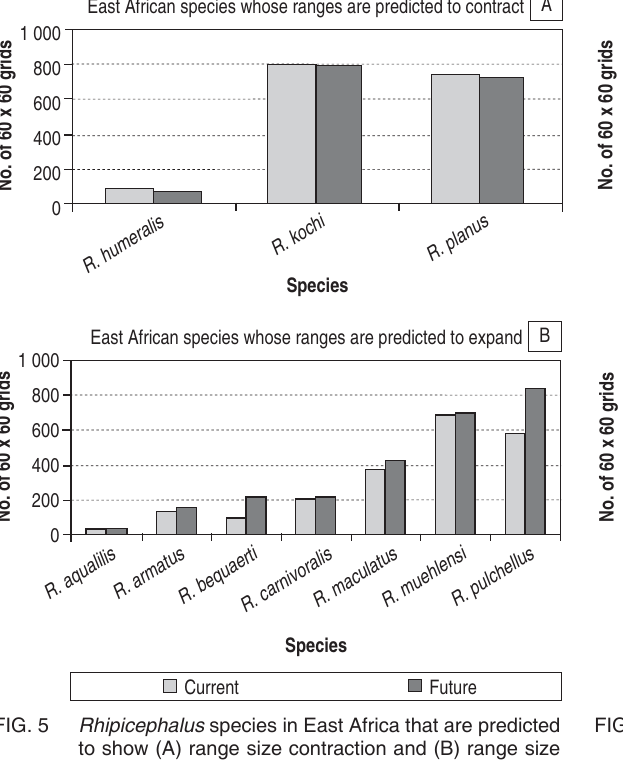
FIG. 5 Rhipicephalus species in East Africa that are predicted to show (A) range size contraction and (B) range size expansion